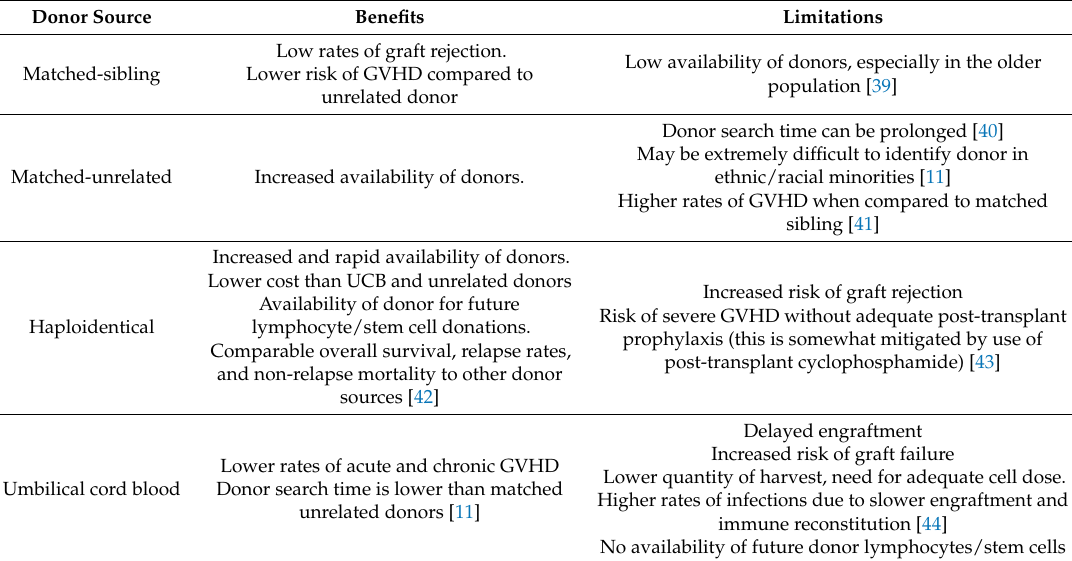
Table 2. Benefits and limitations of the various donor